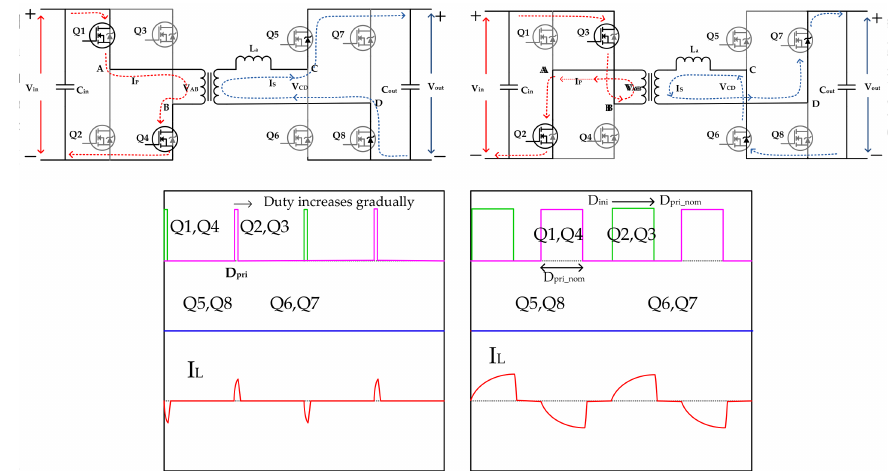
Figure 5. Circuit current flow diagram and PWM (Pulse Width Modulated) signals plot at phase A soft-start mode.